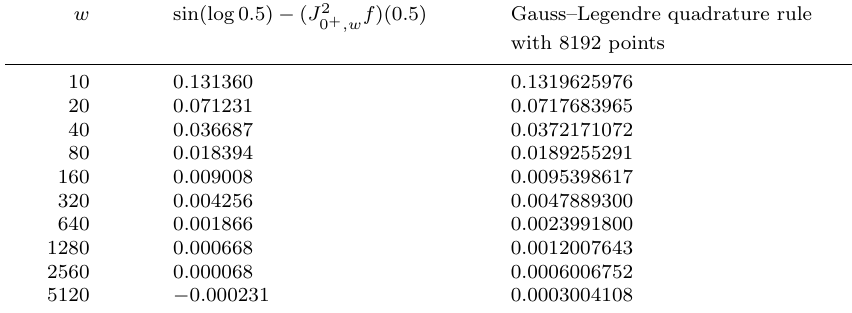
Table 2. Hadamard integrals values for f = sin(log x ) on s = 0 . 5. w sin(log 0 . 5) − ( J 2 f )(0 . 0 + ,w